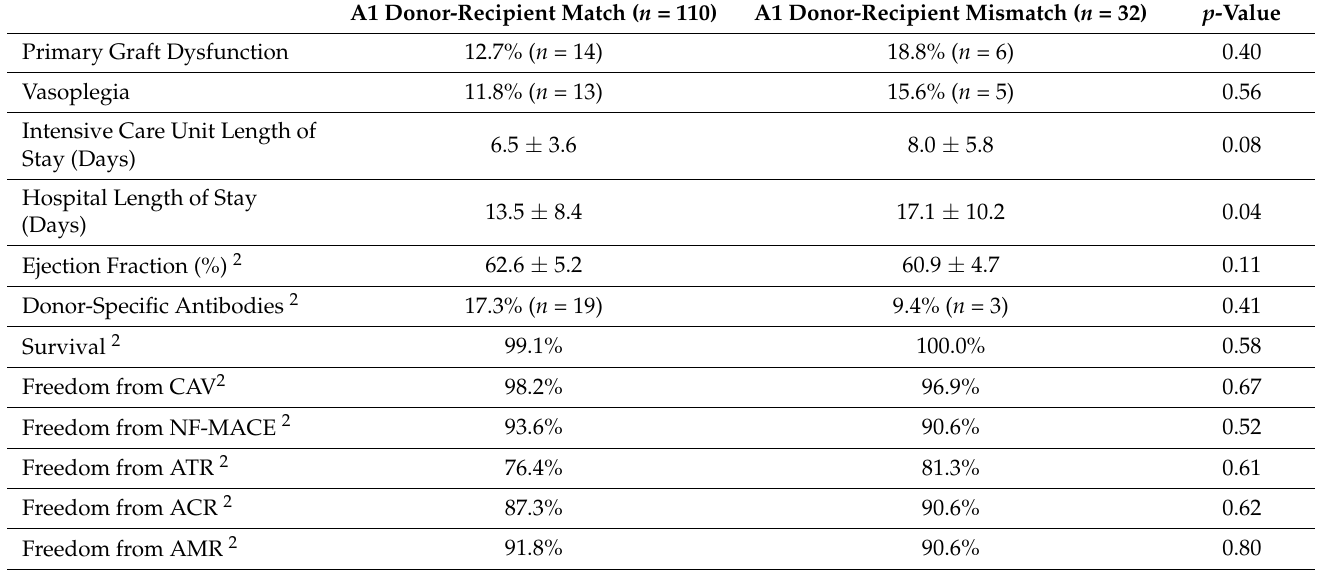
Table 2. Post-Transplant Outcomes 1 .